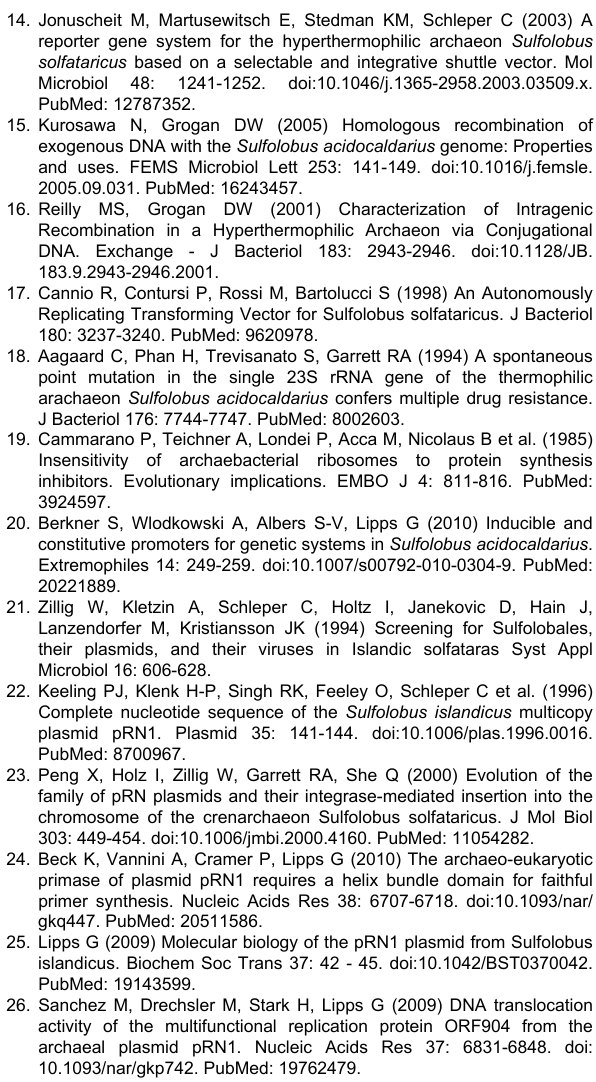
Figure S7. Map of pRSP1-CL and pRSP2-CL. Multiple cloning sites including of HindIII-XhoI-AatII-NruI-PacI-PstI- PvuII-NsiI (MCS) were added to pRSP1 (A) and pRSP2 (B) to generate pRSP1-CL (C) and pRSP2-CL (D) to enhance its utility for cloning.